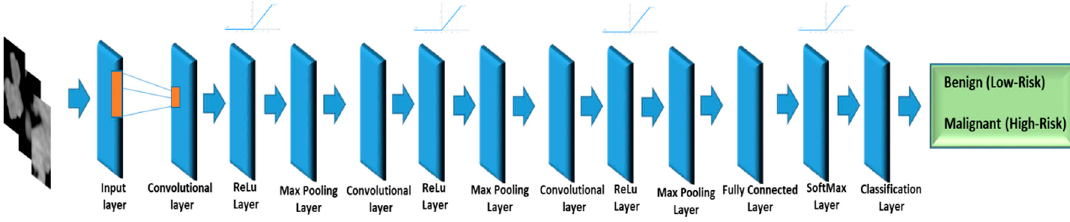
Figure 8. The proposed Deep Convolutional Neural Network pipeline.